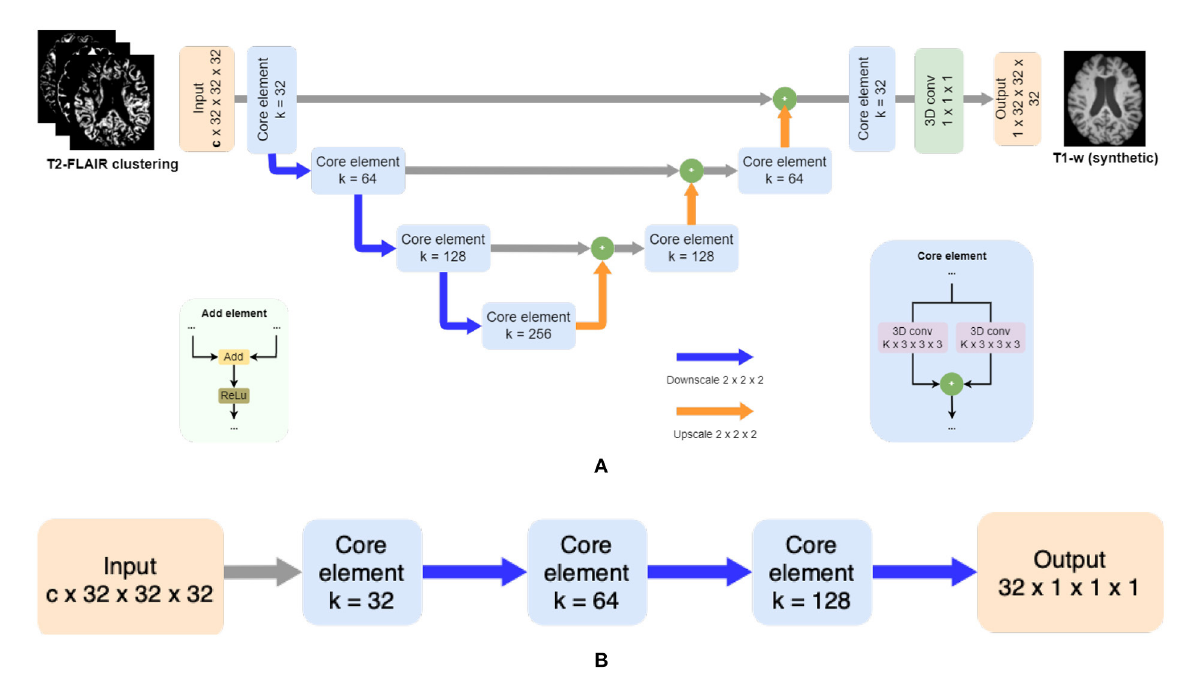
FIGURE2 Adversarial synthesis model which takes as input the T2-FLAIR image clustering together with a T1-w intensity image as ground truth and generates a T1-w synthetic image as output. Core element modules in both architectures are composed of residual layers as described in He et al. (2016) with two convolutional layers (k = 3 x 3 x 3), followed by batch normalization, and finally a pooling layer by striding ( k = 2 x 2 x 2). (A) The generator is a patchwise 3D encoder/decoder architecture where c is the number of clusters. Merged layers are implemented using summation instead of concatenation, using added element modules. (B) The discriminator is a patchwise 3D decoder